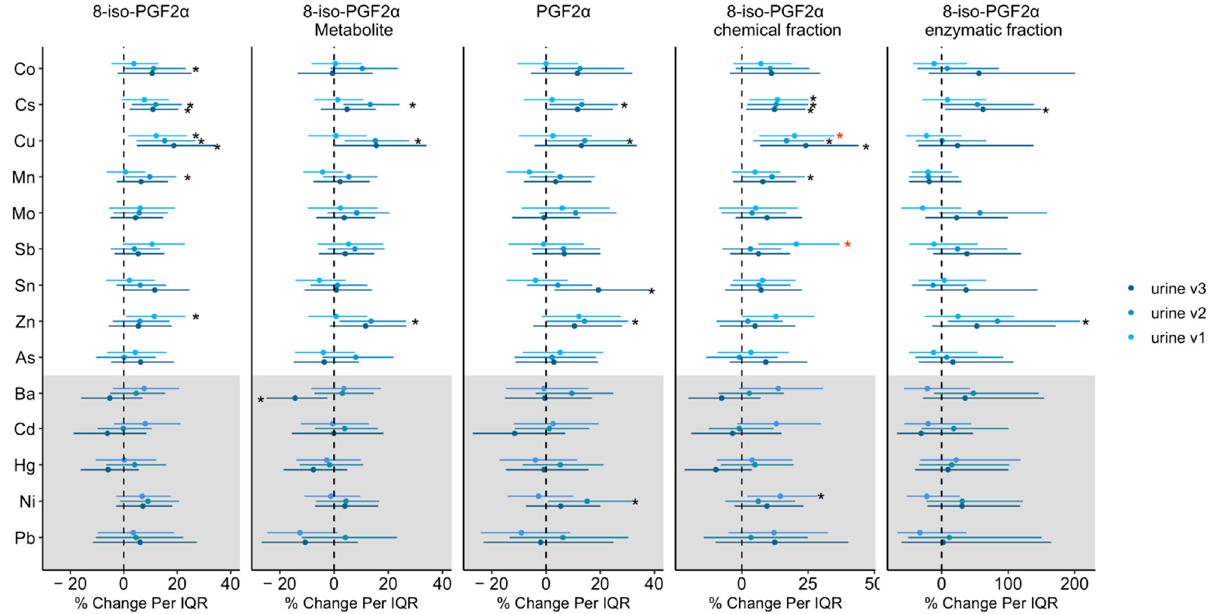
Figure 3 . Percent change in prostanoids associated with urinary metal concentrations by study visit. Effect estimates presented as percent changes (%) for interquartile range (IQR) increase in exposure biomarker concentration. Models were adjusted for study visit, maternal age, maternal education, marital status, pre-pregnancy BMI, and exposure to secondhand smoking. Abbreviations: cobalt (Co); cesium (Cs); copper (Cu); manganese (Mn); molybdenum (Mo); antimony (Sb); tin (Sn); zinc (Zn); arsenic (As); barium (Ba); cadmium (Cd); mercury (Hg); nickel (Ni); lead (Pb). White shading indicates essential metals and grey shading indicates non-essential metals. Since Cs is not regarded as essential to the health of plants or animals nor does it present a hazard to them, Cs was considered as essential metal for the analysis. Black * denotes p value <0.05; red * denotes p value <0.05 and q value (false discovery rate) <0.05.